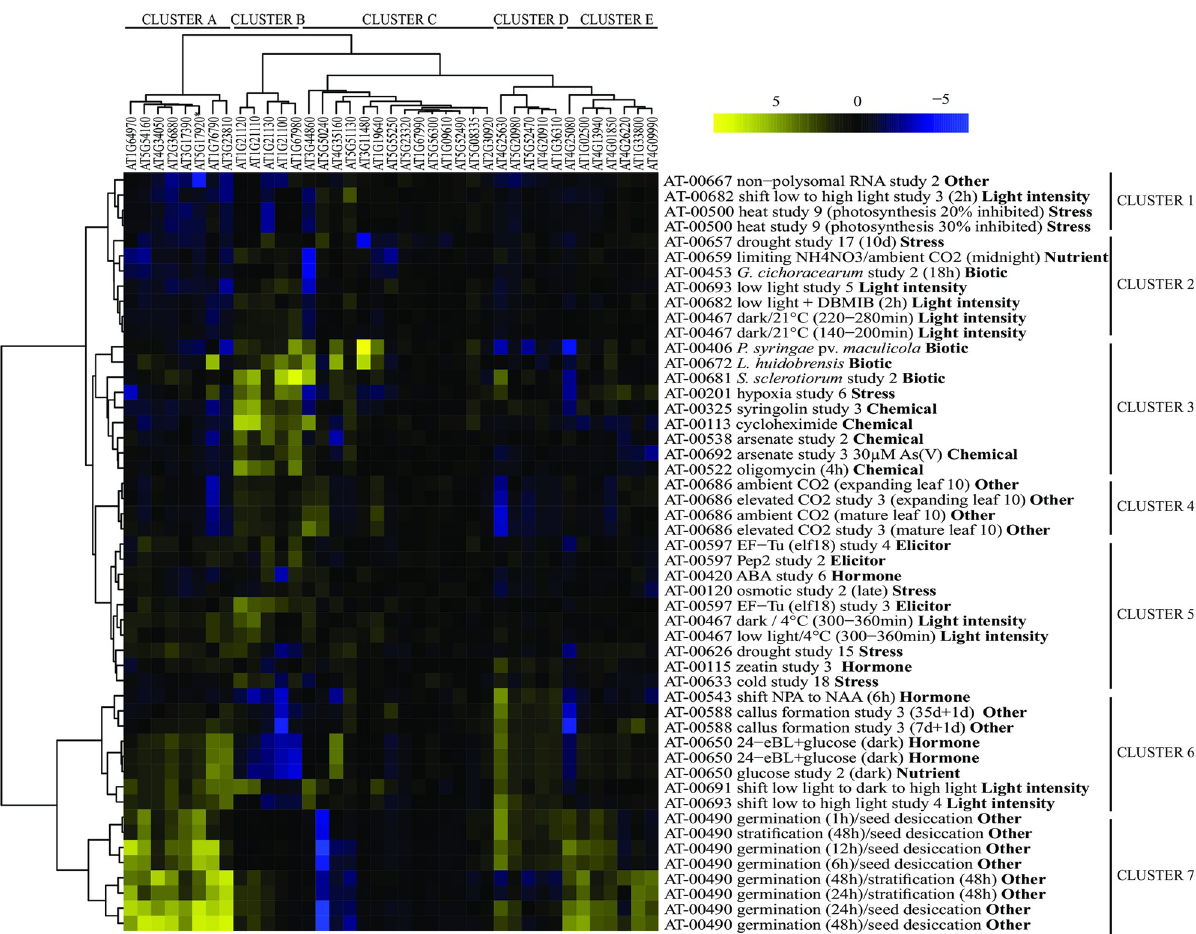
Fig 1. Hierarchically clustered heatmap depicting dynamic adjustments in the transcript abundance for genes encoding O-methyltransferases (O-MTs) and enzymes of the activated methyl cycle in A . thaliana . The analysis was performed using the “Perturbations” tool in GENEVESTIGATOR. Experiments in which at least 60% of the input genes were differently expressed were selected to build the cluster heatmap. The input genes were retrieved from UniProt reviewed database by searching for “O-methyltransferase” and filtering for species ( Arabidopsis thaliana ), and this list was combined with genes encoding the AMC enzymes (S1 Table). � This gene represents both AT5G17920 and AT3G03780 as they were indistinguishable because they share the same probe in Affymetrix Arabidopsis ATH1 microarray chip.